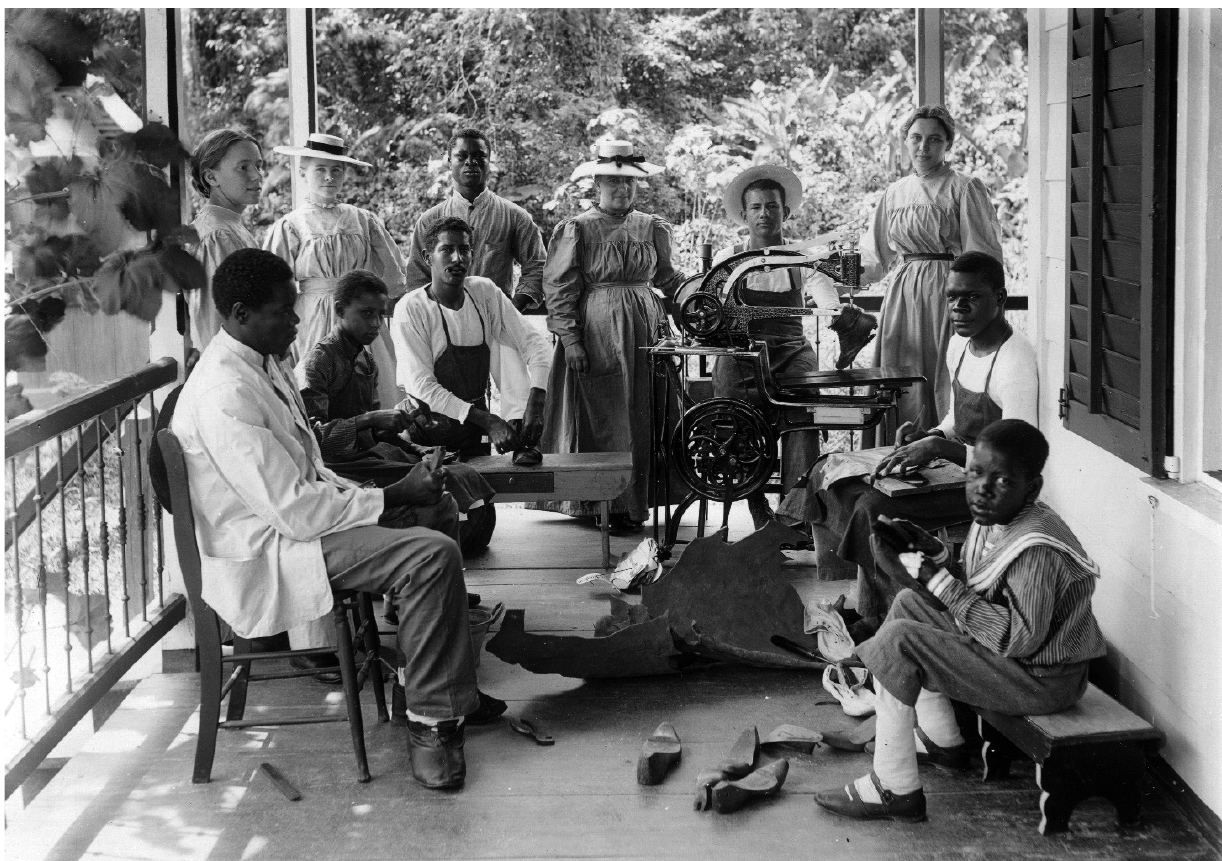
Figure 1. Shoemakers and staff at New Bethesda, Suriname, before 1915. Collection H.W. Bosman. Photographer unknown (Augusta Curiel). Photograph Courtesy National Museum of World Cultures